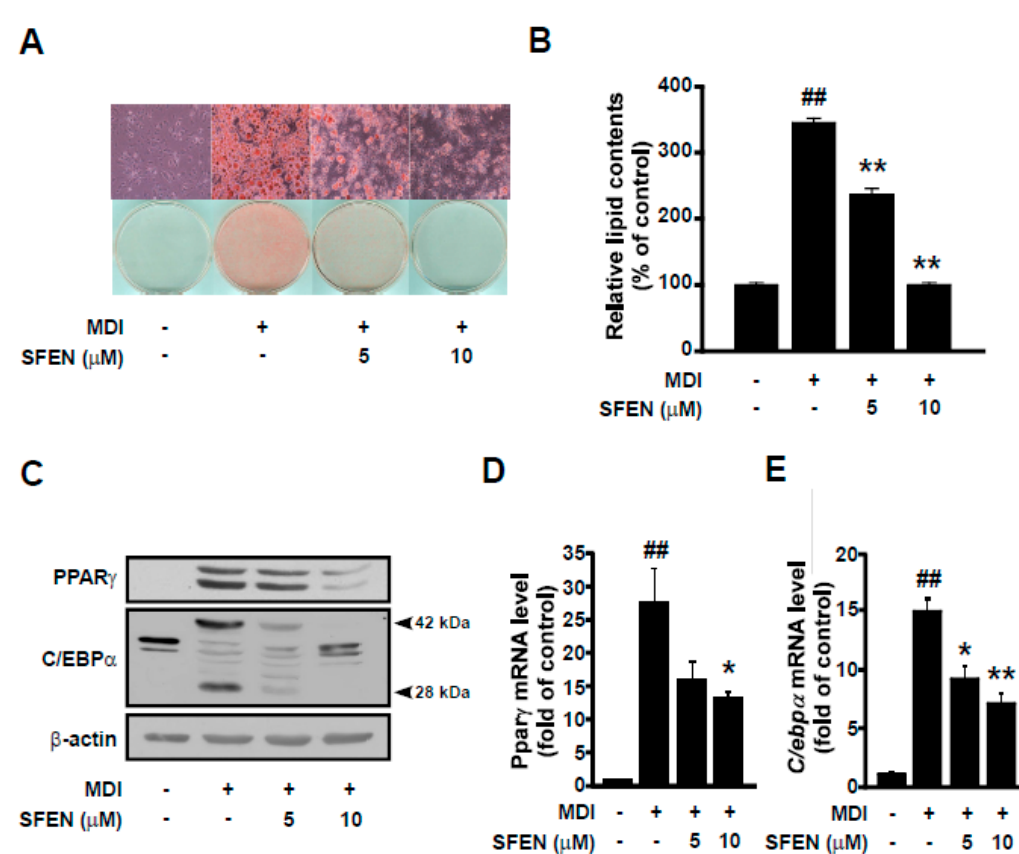
Figure 2. Effects of sulforaphene on differentiation medium-induced adipogenesis and the 229 Figure 2. E ff ects of sulforaphene on di ff erentiation medium-induced adipogenesis and the expression expression of two adipogenic genes—PPAR γ and C/EBP α —in 3T3-L1 pre-adipocytes. ( A ) Image of 230 of two adipogenic genes—PPAR γ and C / EBP α —in 3T3-L1 pre-adipocytes. ( A ) Image of di ff erentiated differentiated 3T3-L1 adipocytes stained with Oil Red O (Magnification: 200×) ( B ) Quantification of 231 3T3-L1 adipocytes stained with Oil Red O (Magnification: 200 × ) ( B ) Quantification of intracellular lipid accumulation in differentiated 3T3-L1 adipocytes. ( C ) Western blot analysis of the 232